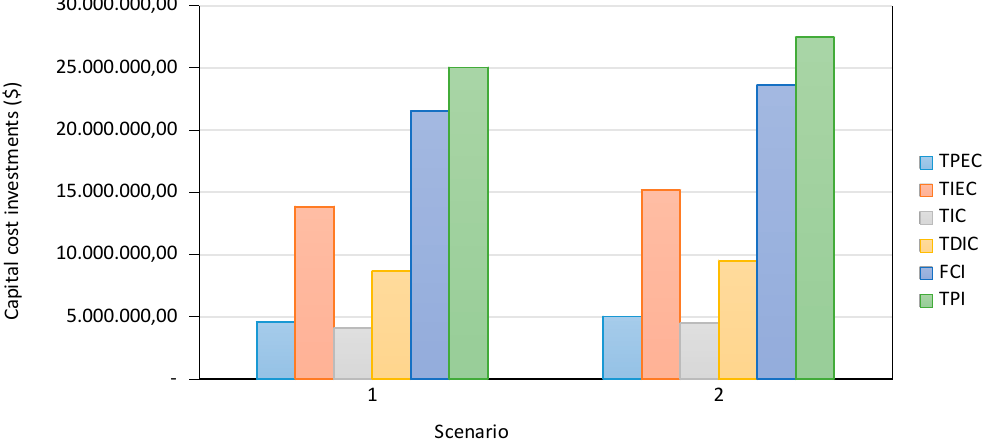
Figure 3. Overall fixed capital costs for Scenario I (evaporation process) and Scenario II (flocculation process. TPEC—Total Purchased Equipment Cost; TIEC—Total Installed Equipment Cost; TIC—Total Indirect Cost; TDIC—Total Direct and Indirect Costs; FCI—Fixed Capital Investment; and TPI—Total